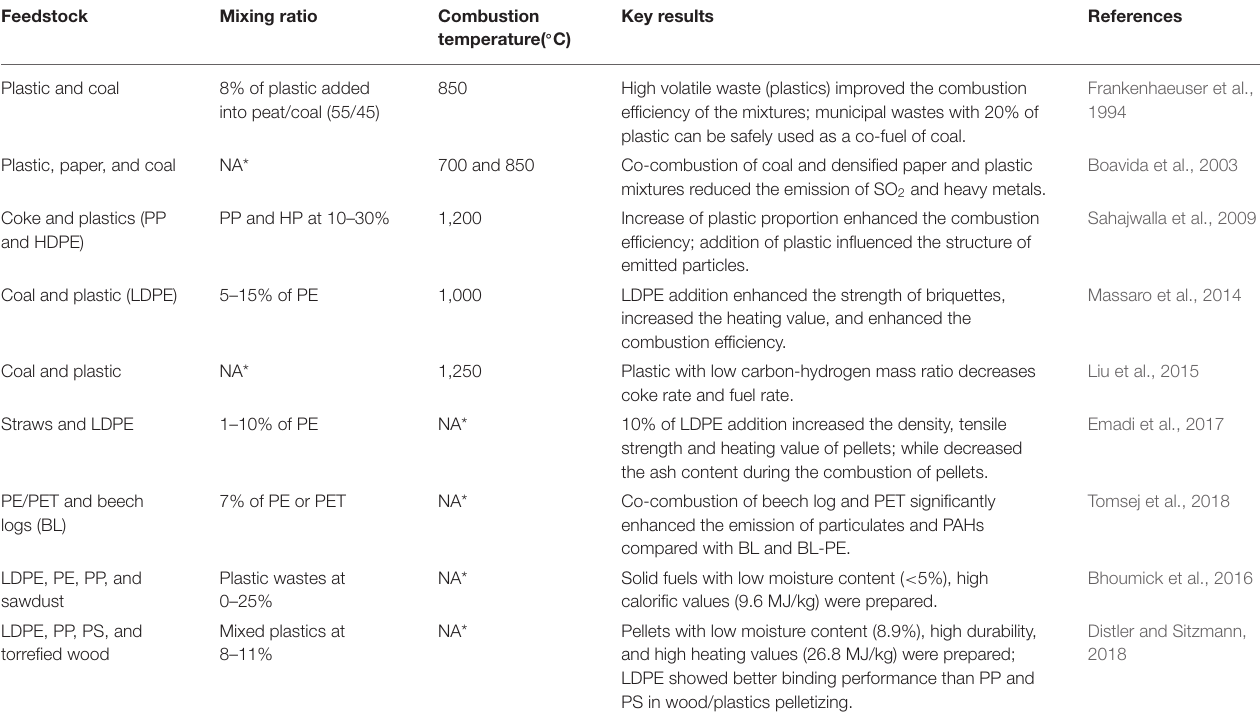
TABLE 1 | Identical studies on solid fuels with plastics as additives or